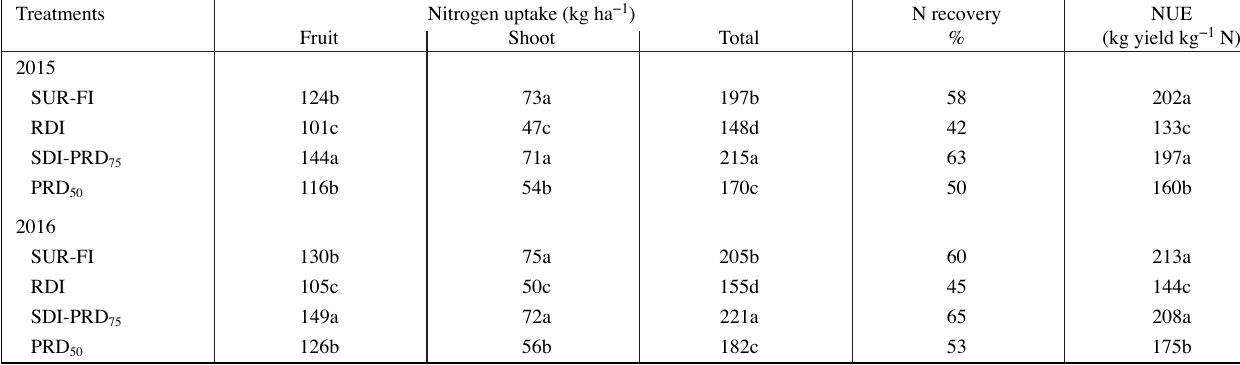
Tab. 3: Nitrogen uptake, N recovery and N use efficiency (NUE) of tomato as affected by different drip irrigation treatments. Treatments